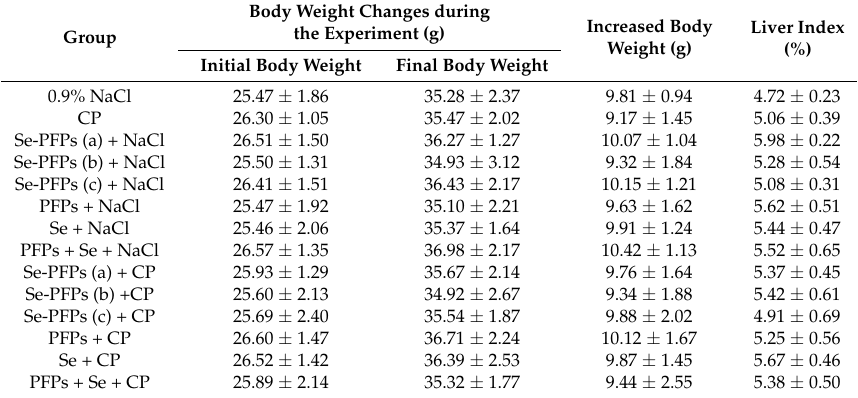
Table 1. Changes in mean body weight and mean liver index of mice after various treatments for 30 days ( n =